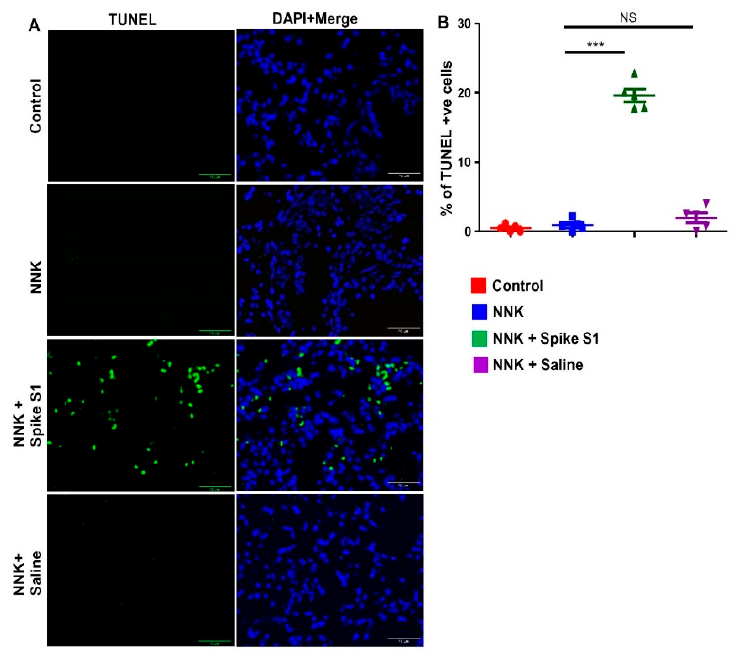
Figure 8. Intranasal administration of recombinant SARS-CoV-2 spike S1 induces apoptosis in lung tumors of NNK-insulted female A/J mice. Female A/J mice (5–6 week old) received two intraperito- neal (i.p.) injections of NNK (50 mg/kg body weight) one week apart. Mice were treated with spike S1 (50 ng/mouse/2 d) intranasally on alternate days starting from 22 weeks of NNK insult for 4 weeks followed by sacrificing mice on 26 weeks. Tumor tissue sections were labeled for TUNEL ( A ) followed by counting of TUNEL-positive cells in two sections (two images per section) of each of five mice per group ( B ). Results are mean + SD of 5 mice per group. *** p < 0.001; NS, not significant. Scale bar = 40 µm.